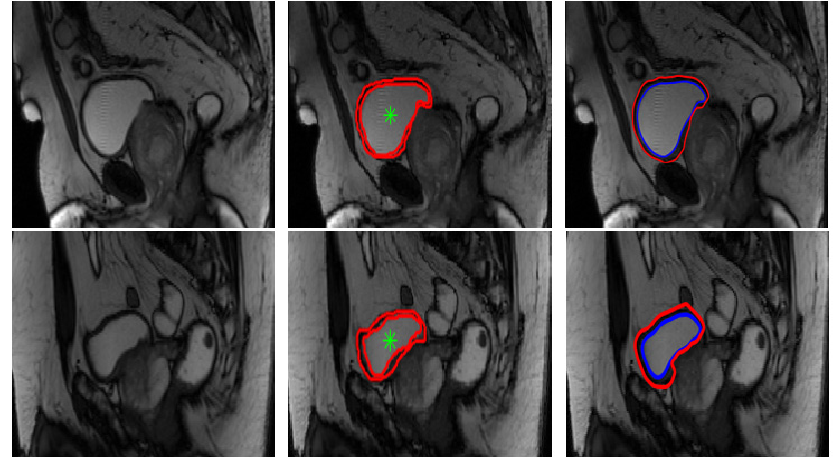
Figure 7. Examples of bladder wall segmentation results. Left column : original T2-weighted imaging. Middle column : bladder wall expert manual segmentation. Right column : Proposed Level Set approach segmentation